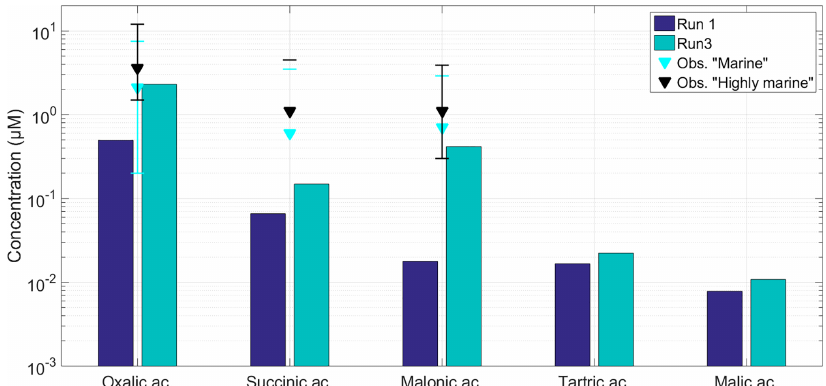
Figure 4. Averaged concentrations of some carboxylic acids calculated by the model during Run 1 (reference) and Run 3 (increased quantities of organics in the particle phase). When available, the concentrations measured in marine and highly marine clouds sampled at Puy de Dôme and reported by Deguillaume et al. (2014) are shown for comparison. Markers represent the mean concentrations, while lower and upper limits of the error bars respectively show the minimum and maximum concentrations measured at this site. For succinic acid, the minimum concentration was below the detection limit of the instrument and is thus not shown.